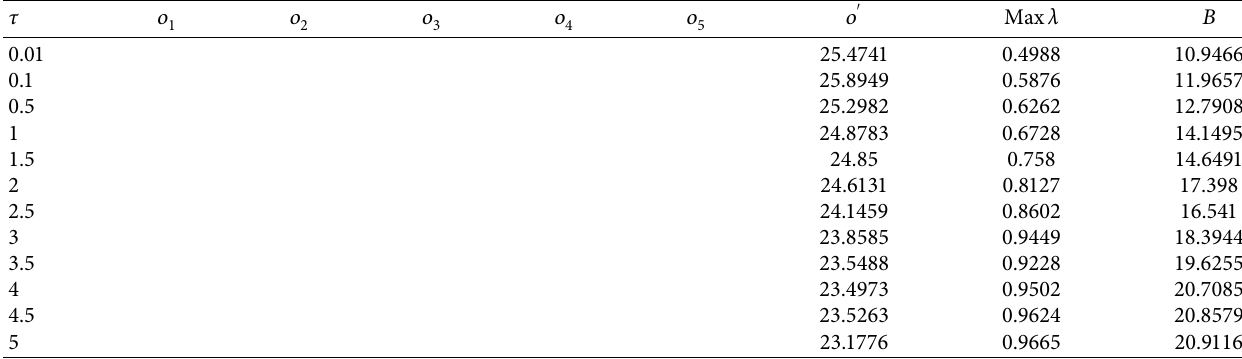
Table 4: Scenario 2: model optimal solution with diferent covariance factors.